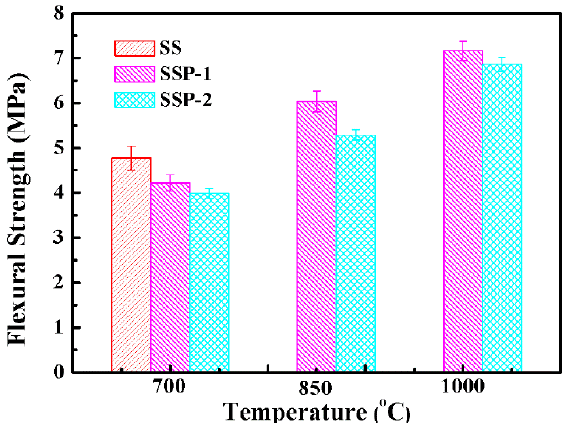
Figure 4. Flexural strength of all samples fired at different temperatures.